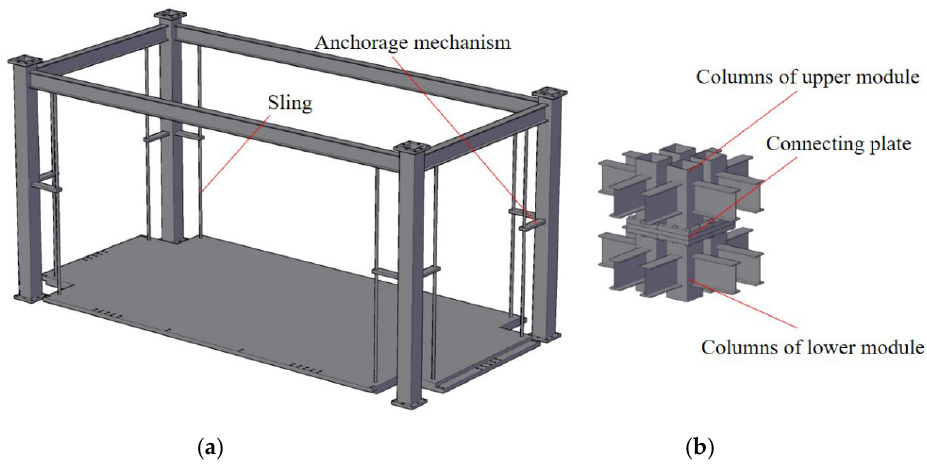
Figure 1. Constructions of ( a ) modules and ( b ) connecting notes.